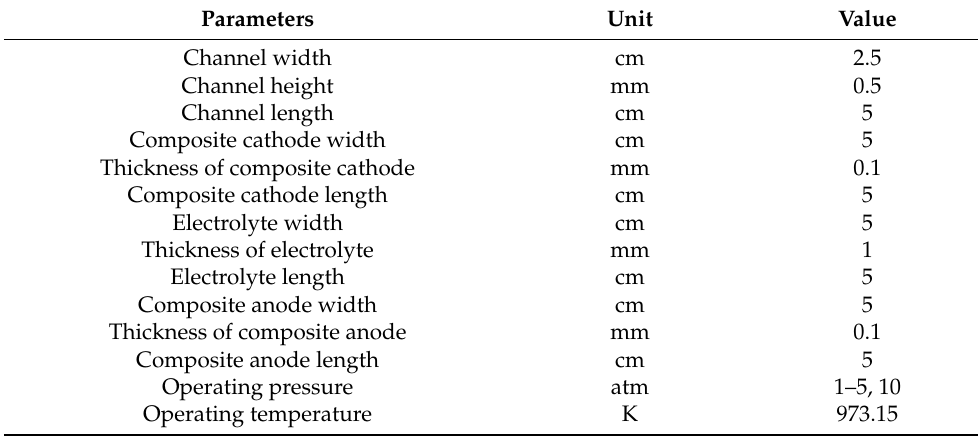
Table 1. Geometric and basic operating parameters [34,38].